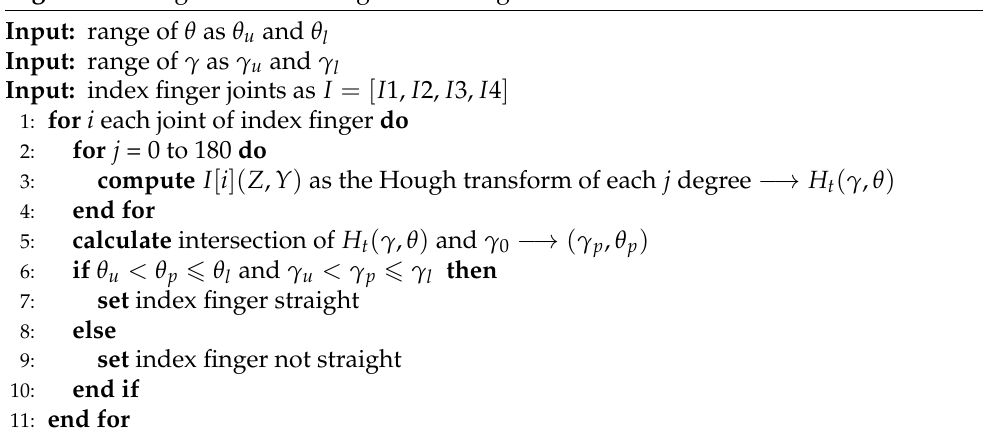
Algorithm 2 Algorithm for straight index finger